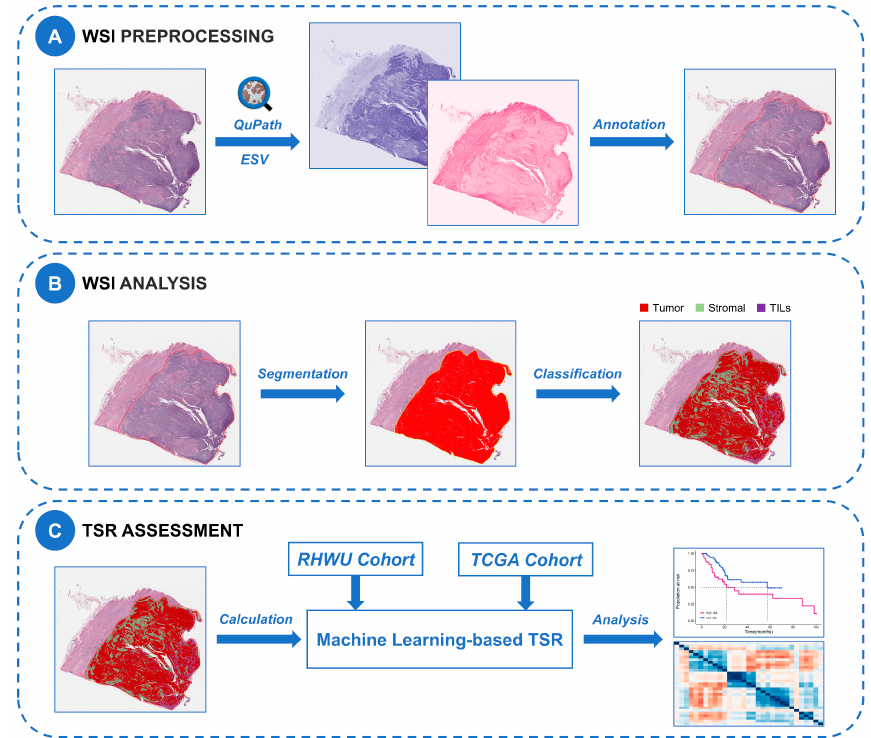
Figure 6. Flow chart of ML-based WSI processing and analysis in this study. ( A ) WSI reprocessing. All WSIs were loaded in QuPath, normalized for staining with the ESV function, and annotated by pathologists. ( B ) WSI analysis. We used the watershed cell detection method for cell segmentation, and then trained an optimal neural network for cell classification. ( C ) TSR assessment. The number of cells in all categories was counted to calculate TSR, and the correlation of TSR with prognosis and gene expression association was analyzed in two dependent cohorts. WSI, whole slide image; ESV, estimated staining vector; TSR, tumor-stroma ratio; TILs, tumor-infiltrating